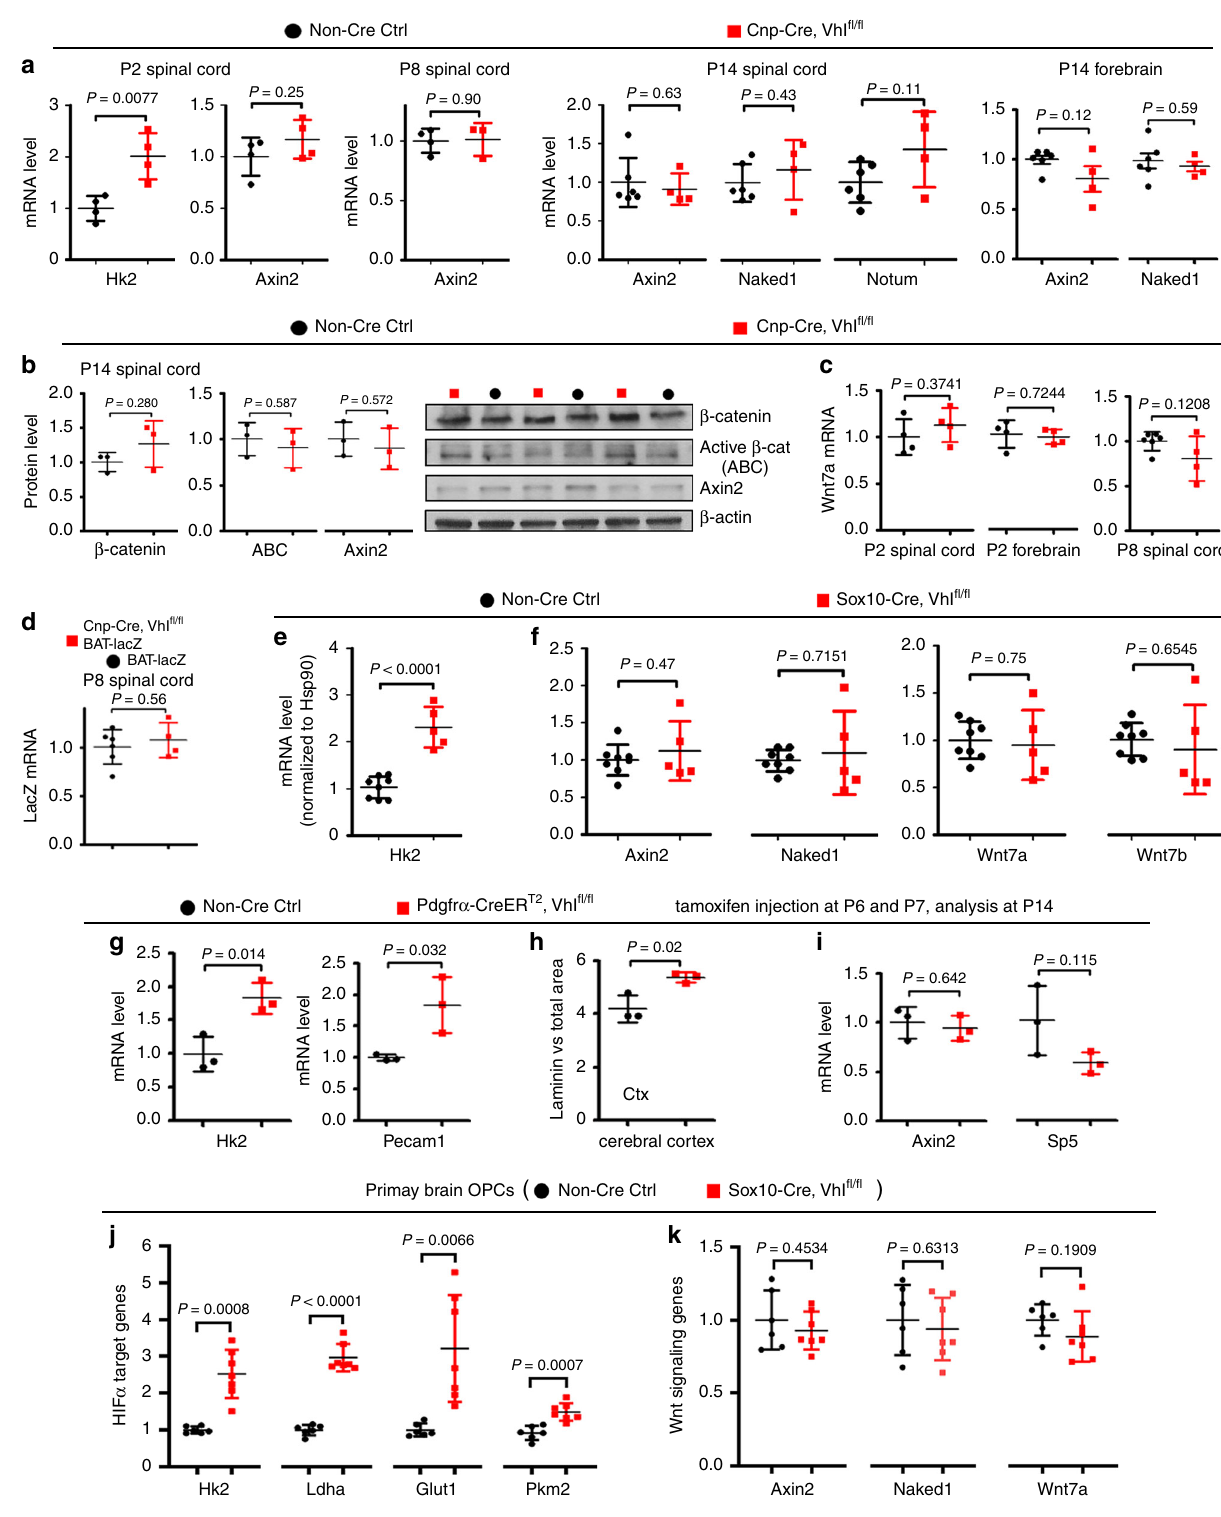
conditional Pdgfr α -CreER T2 :Vhl fl / fl strain in which Pdgfr α - CreER T2 elicited a greater than 85% of recombination ef fi ciency and speci fi city in early postnatal oligodendrocyte progenitor cells (OPCs) (Supplementary Fig. 7). Tamoxifen-induced VHL abla- tion in OPCs resulted in HIF α stabilization and elevated angiogenesis, as demonstrated by signi fi cant increase in the expression of HIF α target gene Hk2 and EC-speci fi c